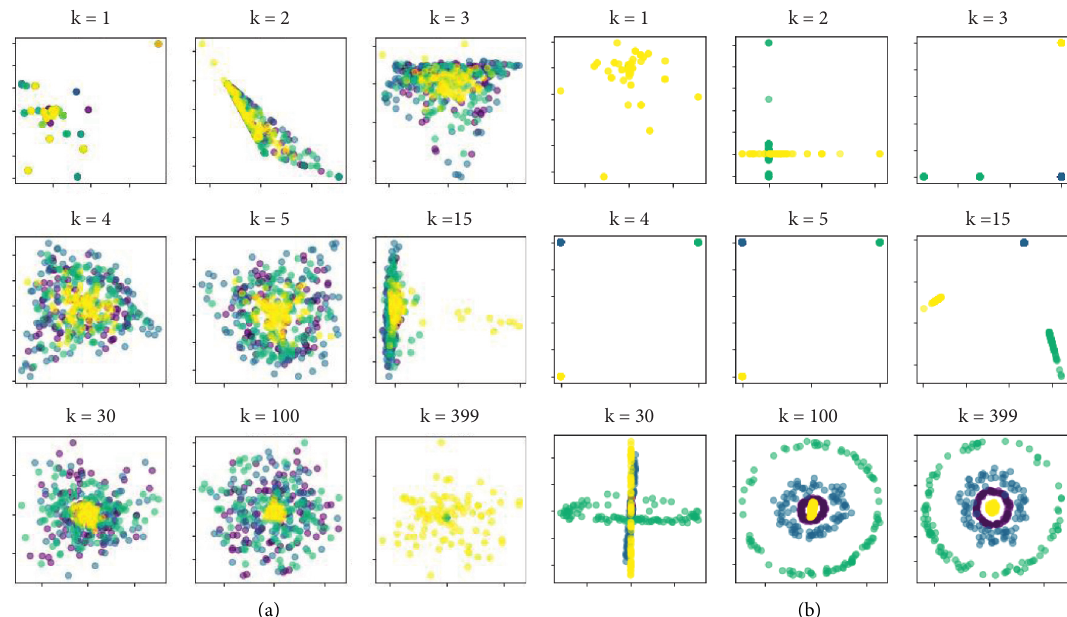
Figure 3: Results of LLE under the different value of K; (a) LLE of bearing fault data; (b) LLE of airborne fuel pump fault